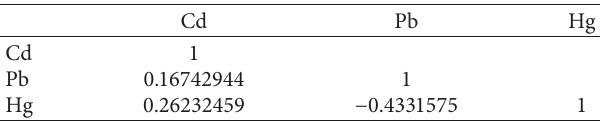
Table 6: Matrix of correlation between the different trace metals in different fish species.